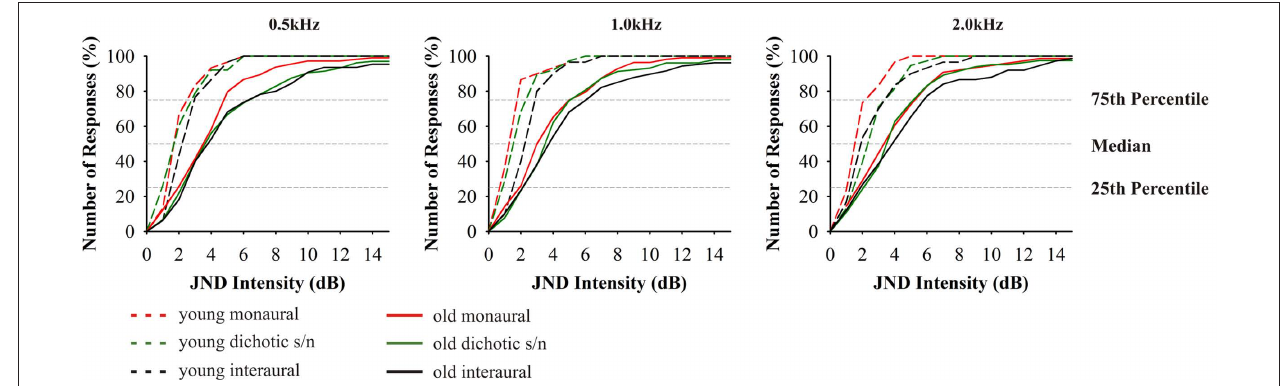
65–89 ( n = 59) solid. Data from 20- to 29-year-old subjects taken from Bungert-Kahl et al. (2004). Older subjects mostly performed poorer and showed a wider variation of threshold values than younger subjects. The best performances at the 25th percentiles were in a narrow range with the young, while the 75th percentiles show values elevated by 3–4 dB.